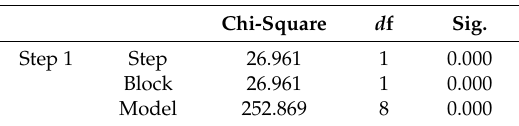
Table 4. Omnibus tests of model